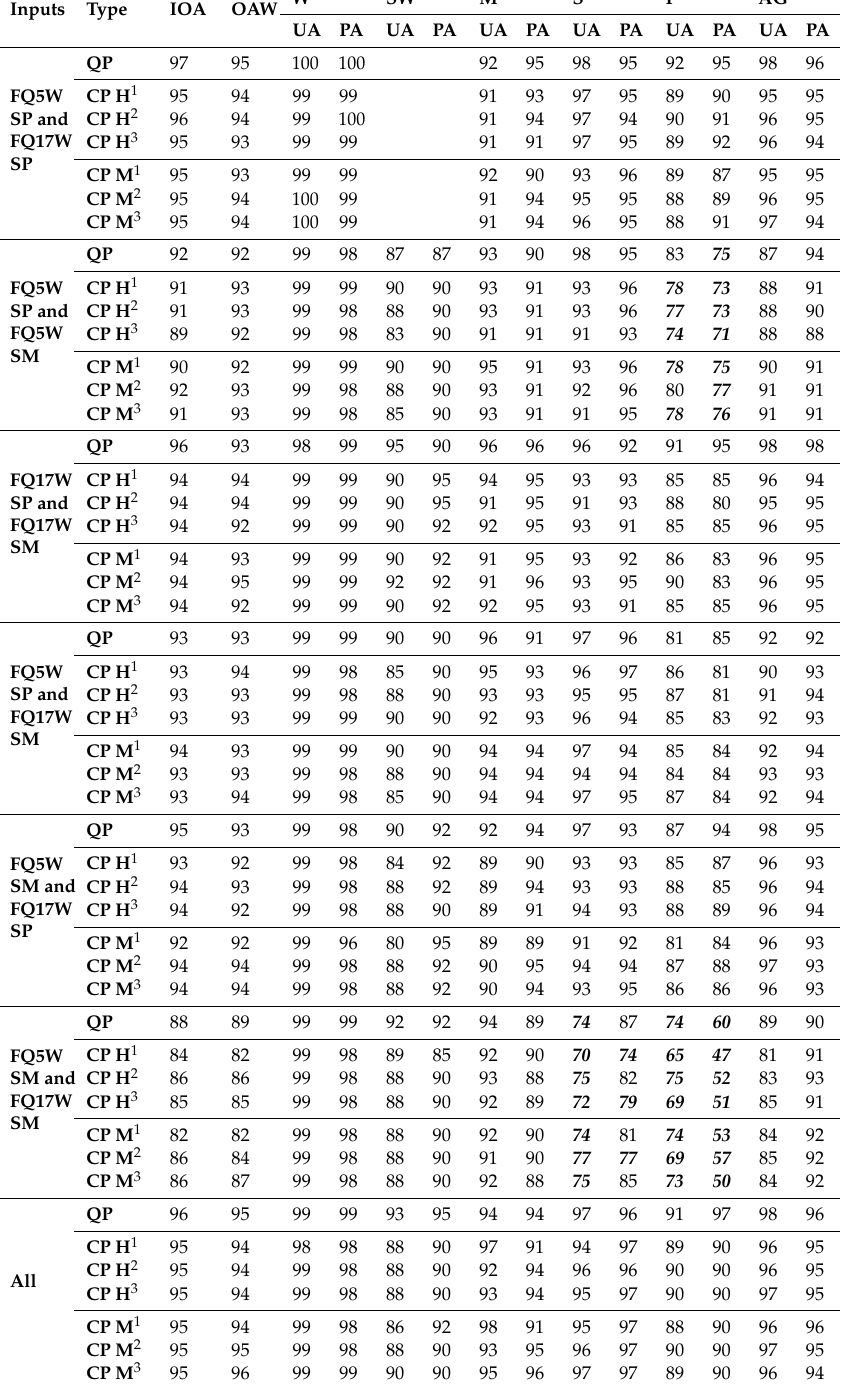
Table A3. Independent overall accuracies (IOA), independent overall accuracies for wetlands only (IOAW), and user’s (UA) and producer’s (PA) accuracies for models based on multi-angle/temporal QP, and the first ( 1 ), second ( 2 ), and third ( 3 ) simulations of high (H) and medium (M) resolution CP SAR data classified in combination with the high spatial resolution DEM and DSM data. Values ≤ 80% are bolded, and italicized to identify relatively high and low accuracies for a given class. Spring and summer images are abbreviated SP and